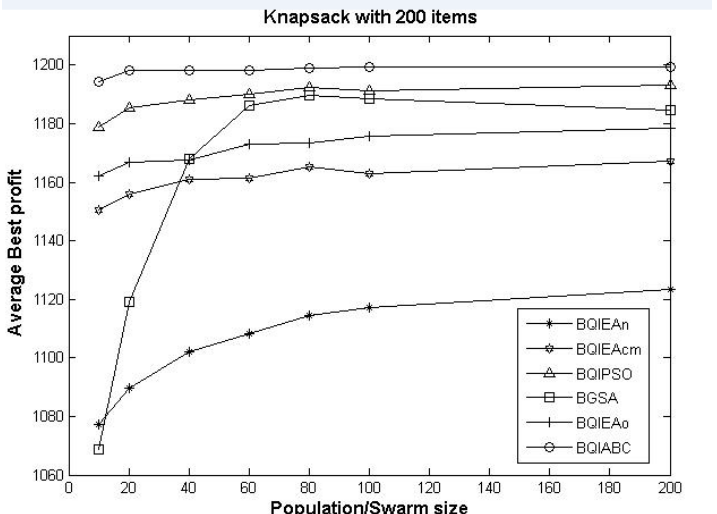
Figure 4. Effect of population size on average best profits obtained by BQIEAn, BQIEAcm, BQIEAo, BQIPSO, BGSA, and the proposed algorithm. The different swarm sizes are 10, 40, 60, 80, 100, and